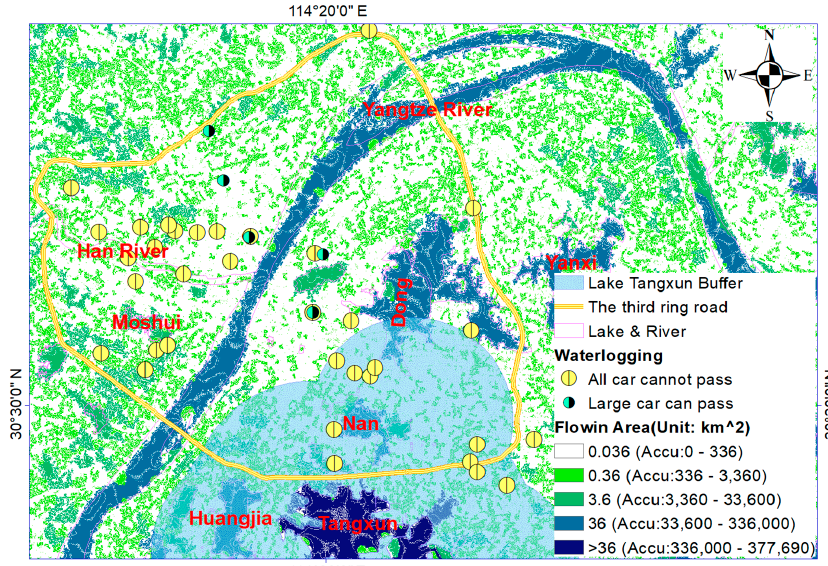
Figure 7. Flow accumulation representing the flow in the area, according to the proposed method. The five color types are accumulations of 336, 3360, 33,600, 336,000, and above 336,000, respectively. Furthermore, the basic water unit is 8.4 in this method, such that the cell’s quantity of each type of accumulation element in corresponding to the flow path is 40, 400, 4000, 40,000, and above 400,000, respectively.